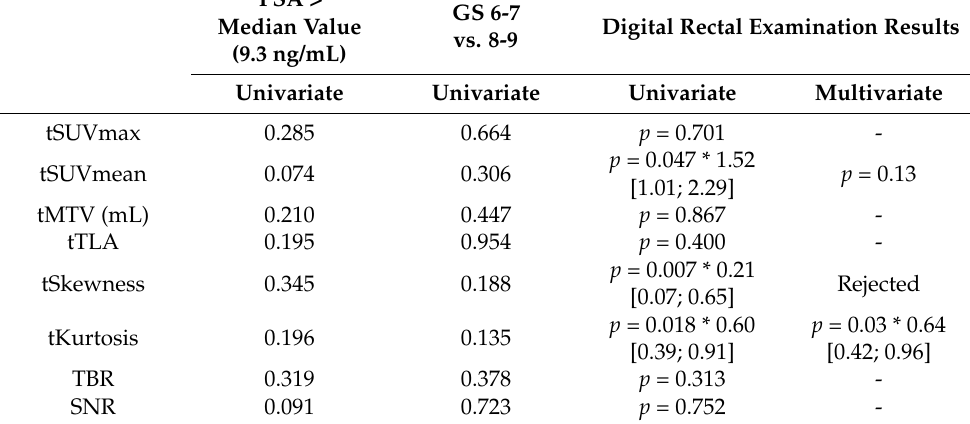
Table 2. Univariate and multivariate analysis performed for PSA, Gleason Score, and Digital Rectal Examination results prediction. If p -value is statistically significant (<0.05, marked by an asterisk), OR and 95% CI are presented. Only p -value is reported if not significant. PSA, prostate-specific-antigen; SNR, Signal-to-noise ratio; tMTV, metabolic tumor volume of the lesion; tTLA, total lesion activity of the lesion; TBR, Tumor-to-background ratio.